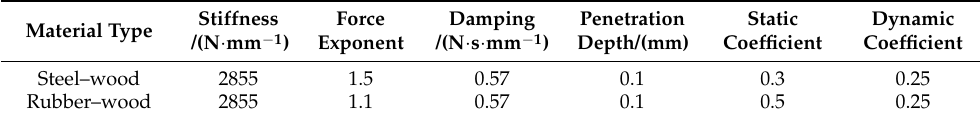
Table 1. Contact parameters of the different materials.